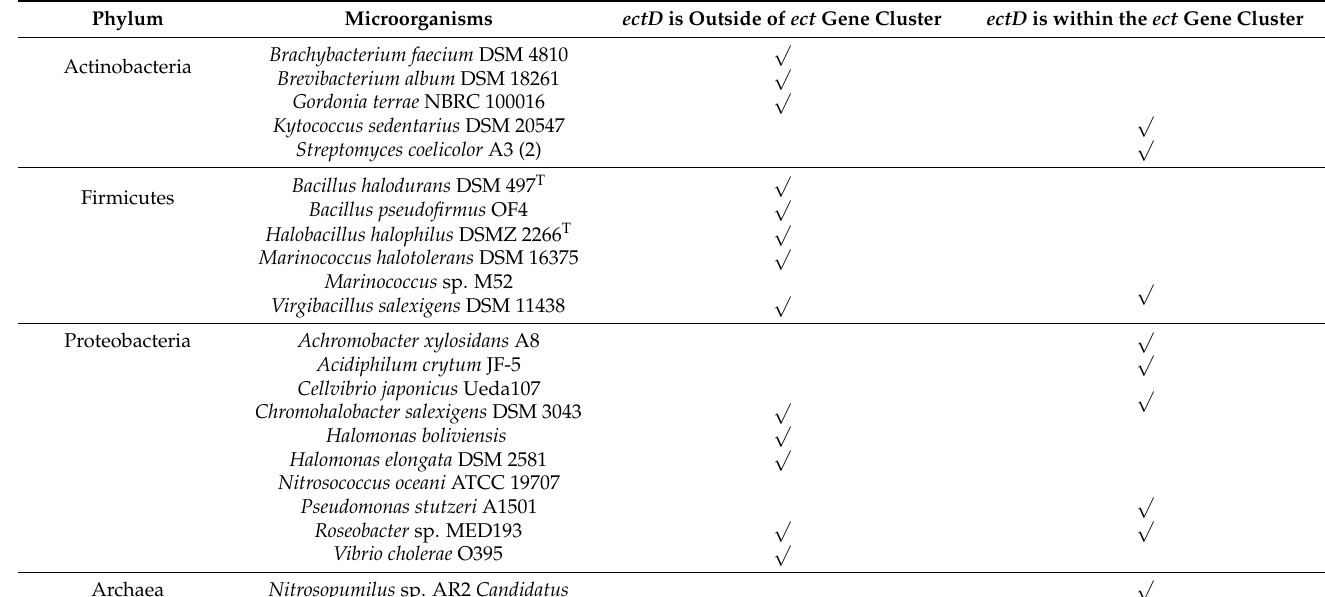
Table 1. Summary of several potential microbial ectoine and hydroxyectoine producers with ectoine √ biosynthetic gene cluster. “ ” indicates whether the ectD is located within/outside of the ect gene cluster (adapted from